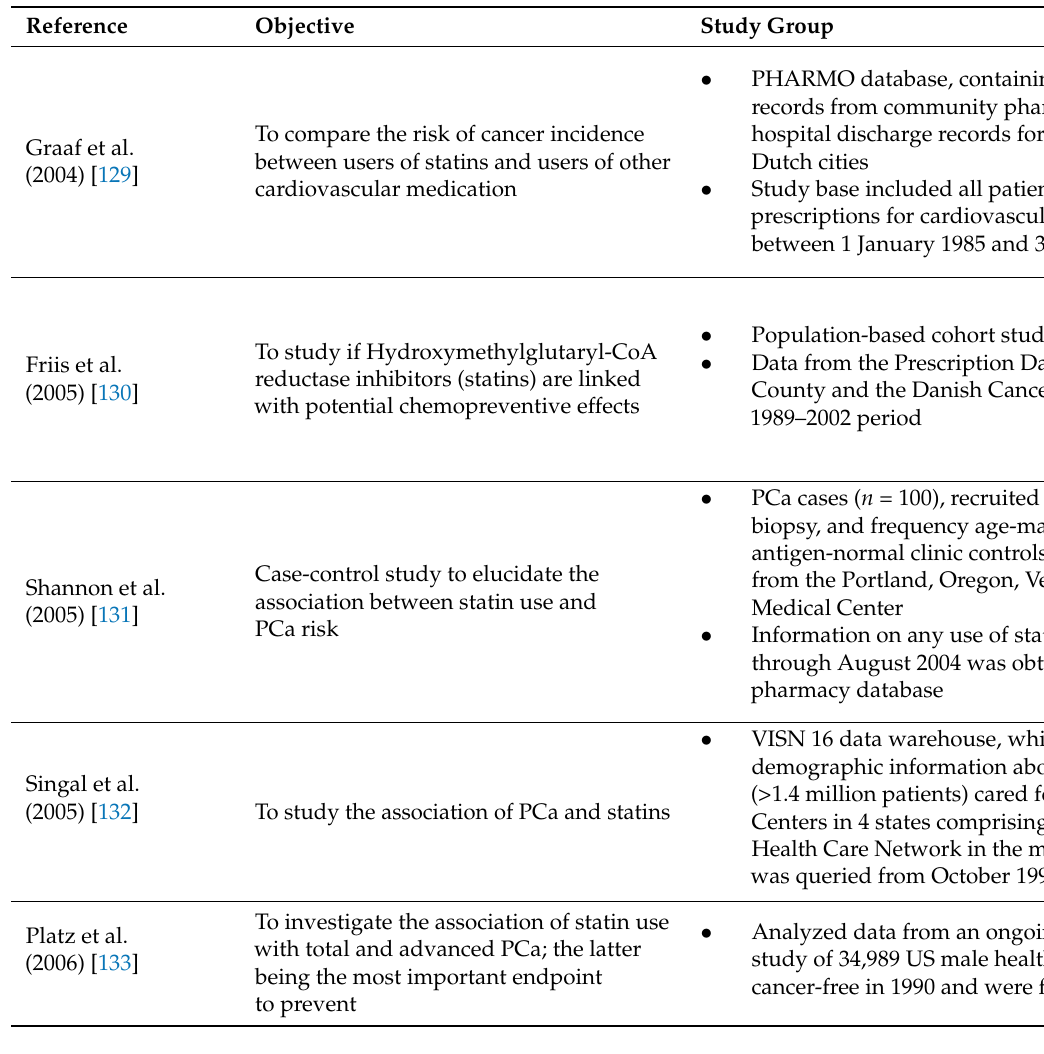
Table 2. Summary of studies on statin use and PCa from 2004 to